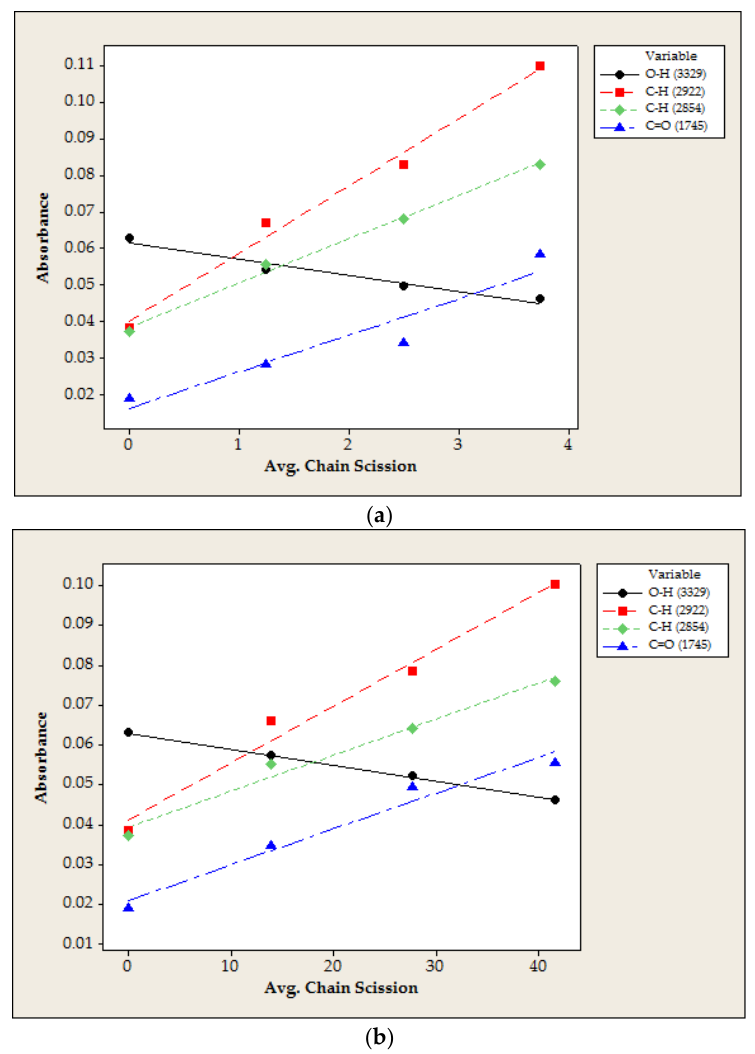
Figure 9. Intensity of the absorbance peaks of the functional groups as a function of the average chain scissions of paper samples at aging temperatures of ( a ) 120 °C ( b ) 150 °C.